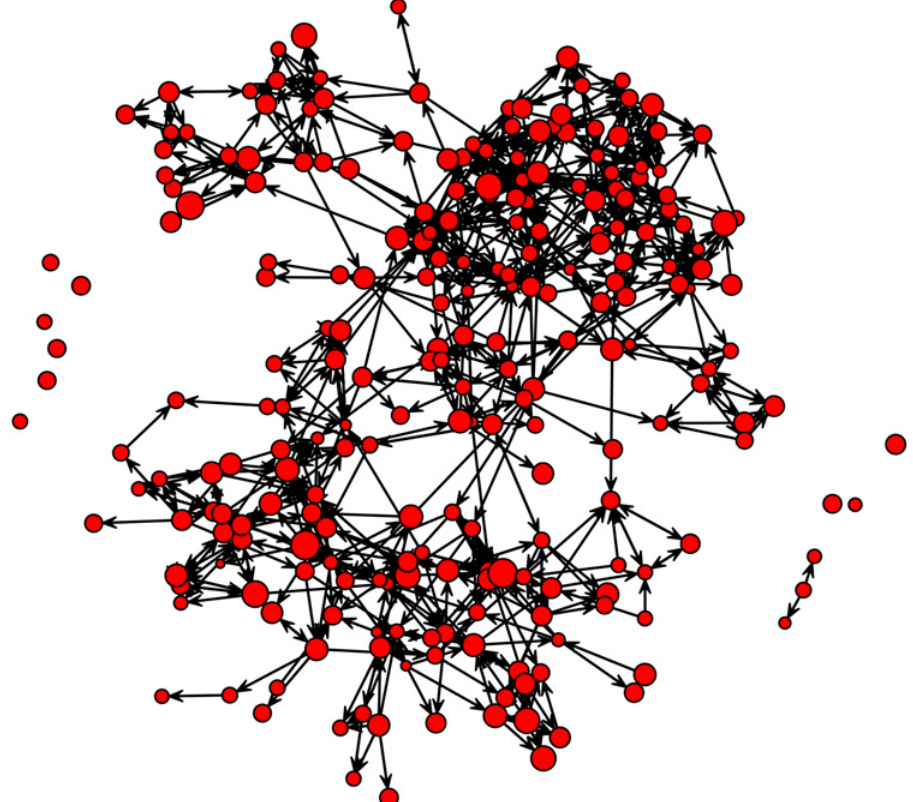
Fig 1. Directed friendship network in a South Korean high school. Circles and arrows show individuals and friendship, respectively. The diameter of the circle shows relative level of individual prosociality (online version in color).